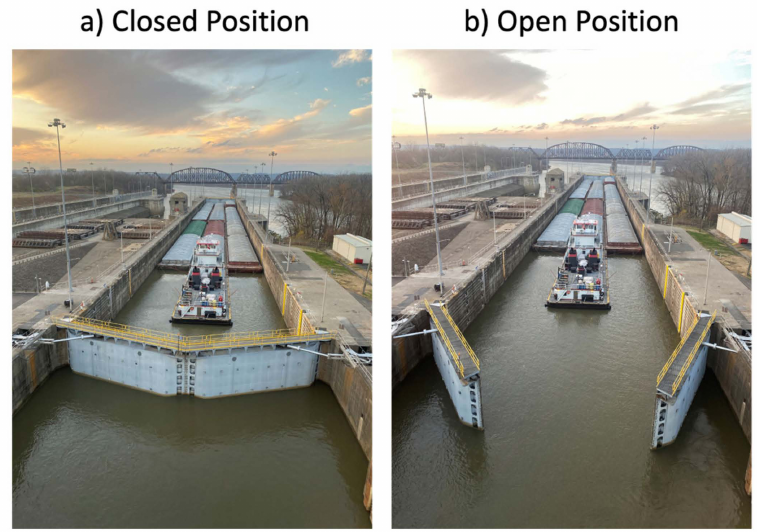
Figure 4. Horizontal miter gate ( a ) the miter gate is in the closed position and ( b ) the miter gate is in the open position